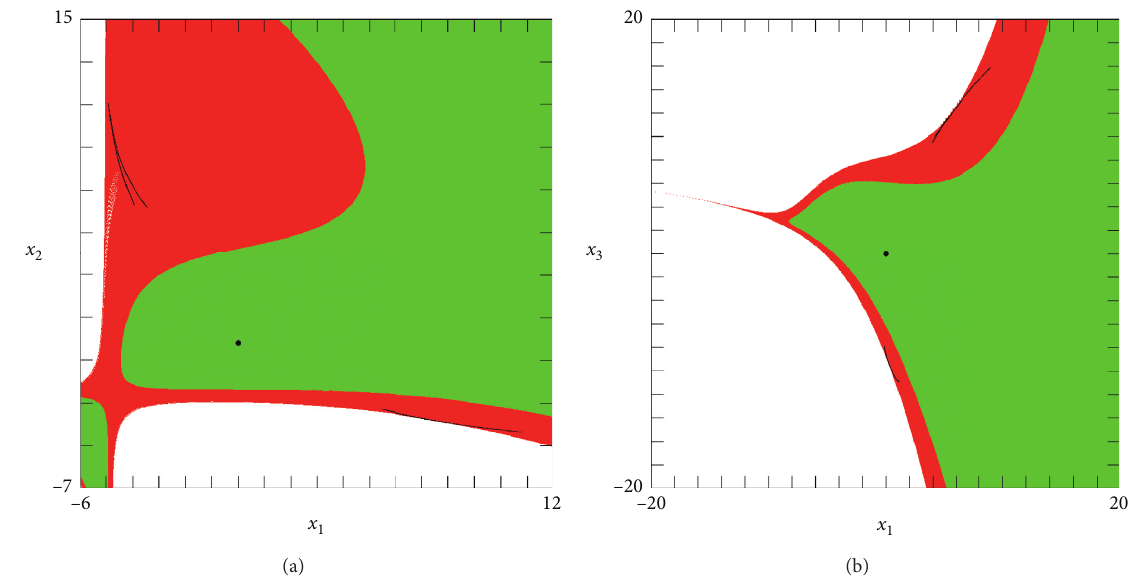
Figure 2: Basin of attraction of the chaotic system (1) viewed along the plane x